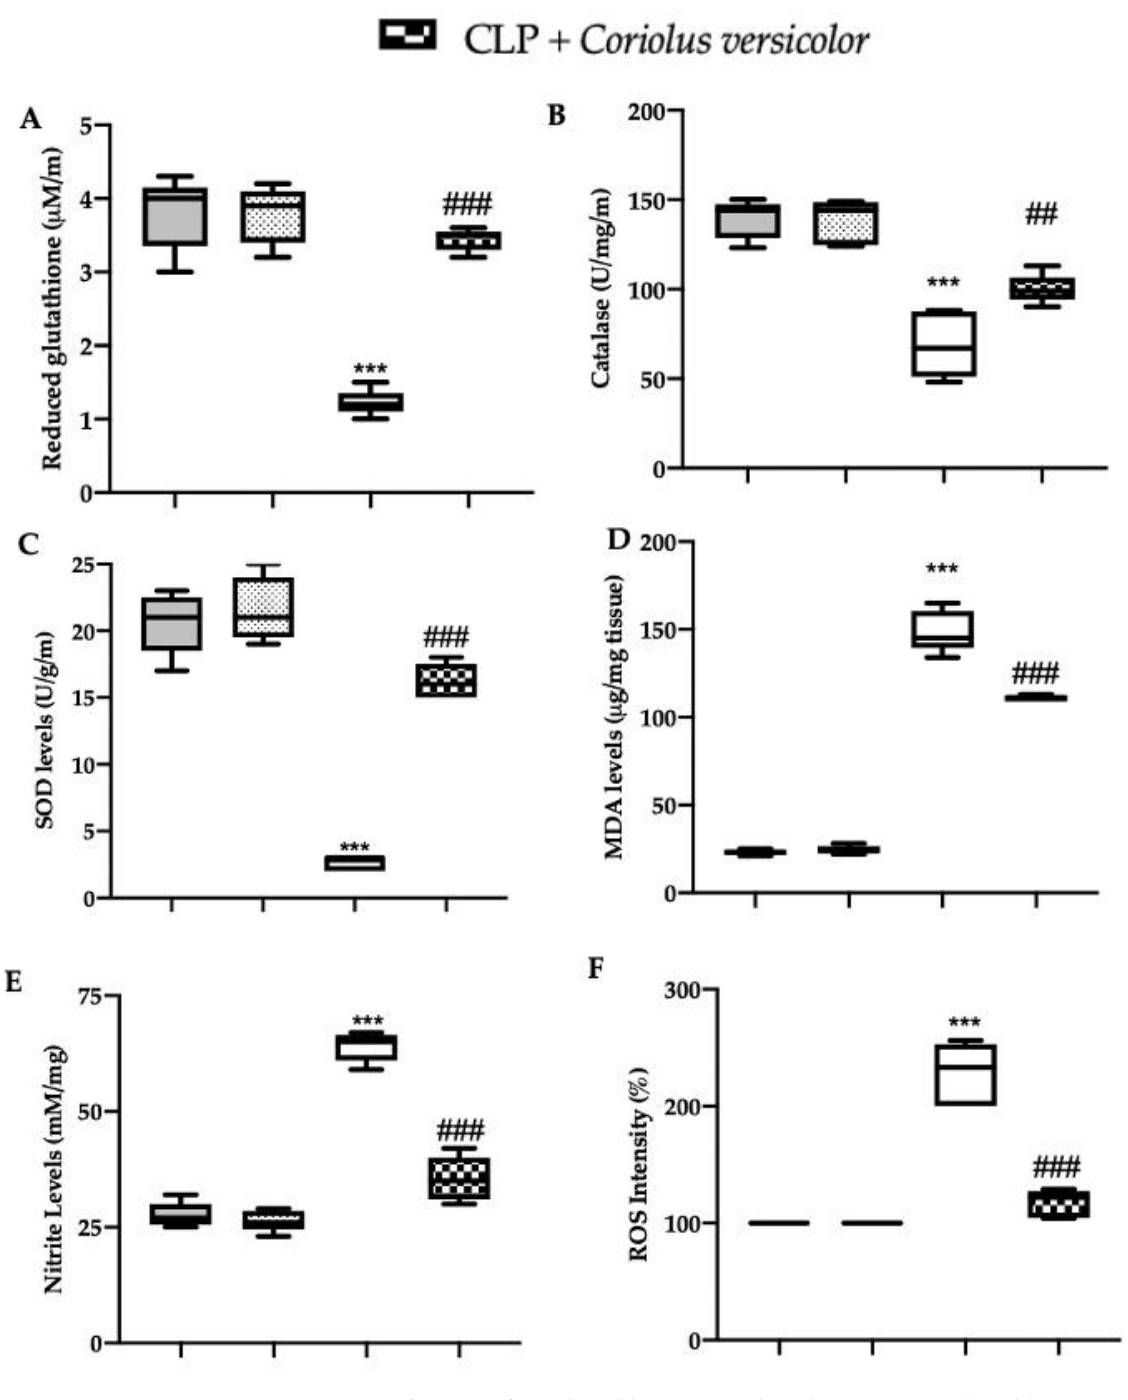
Figure 12. Coriolus versicolor reduced hippocampal oxidative stress induced by CLP 28 days after surgery. Glutathione (GSH) levels ( A ); Catalase ( B ) and superoxide dismutase (SOD) ( C ) activity; Malondialdehyde (MDA) ( D ), Nitrite ( E ) and reactive oxygen species (ROS) levels ( F ). *** p < 0.001 vs. control, ## p < 0.01 vs. CLP, ### p < 0.001 vs. CLP.